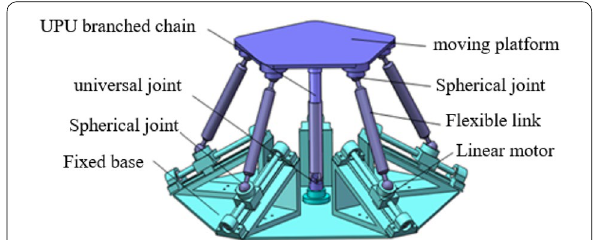
Figure 1 General 5-PSS/UPU parallel mechanism